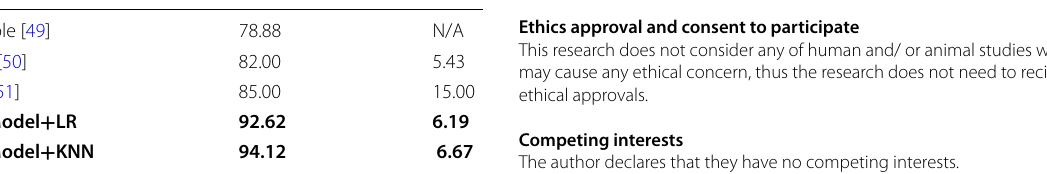
Table 3 Comparison between our model and existing approaches